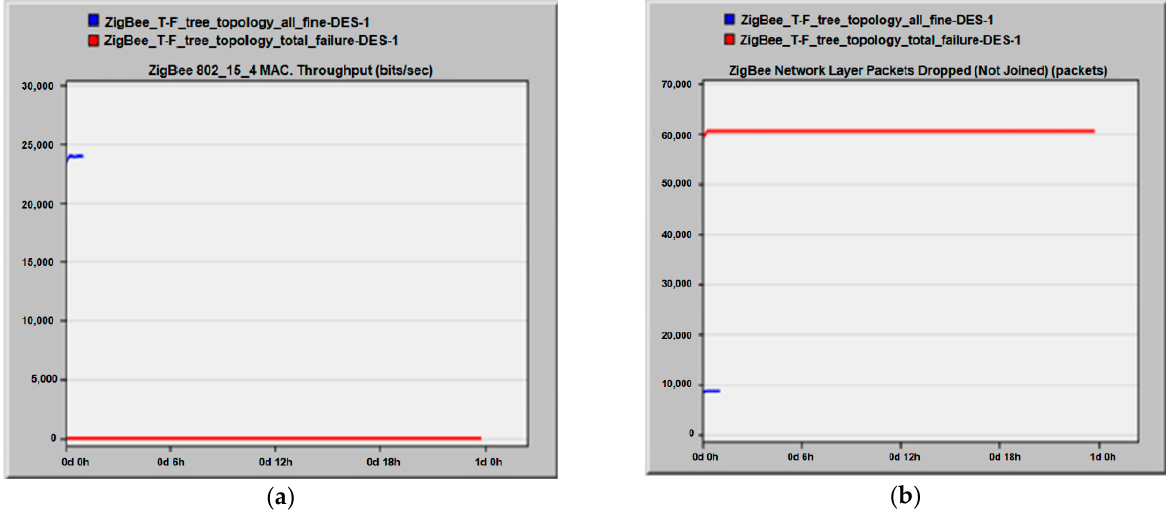
Figure 9. ( a ) The network throughput in bits per second; ( b ) Number of packets rejected during transmission.